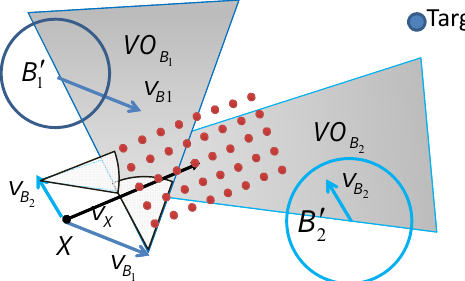
Figure 4. Illustration of the VO model of multiple mobile objects. B 1 and B 2 are two mobile objects. The shaded areas show VO B